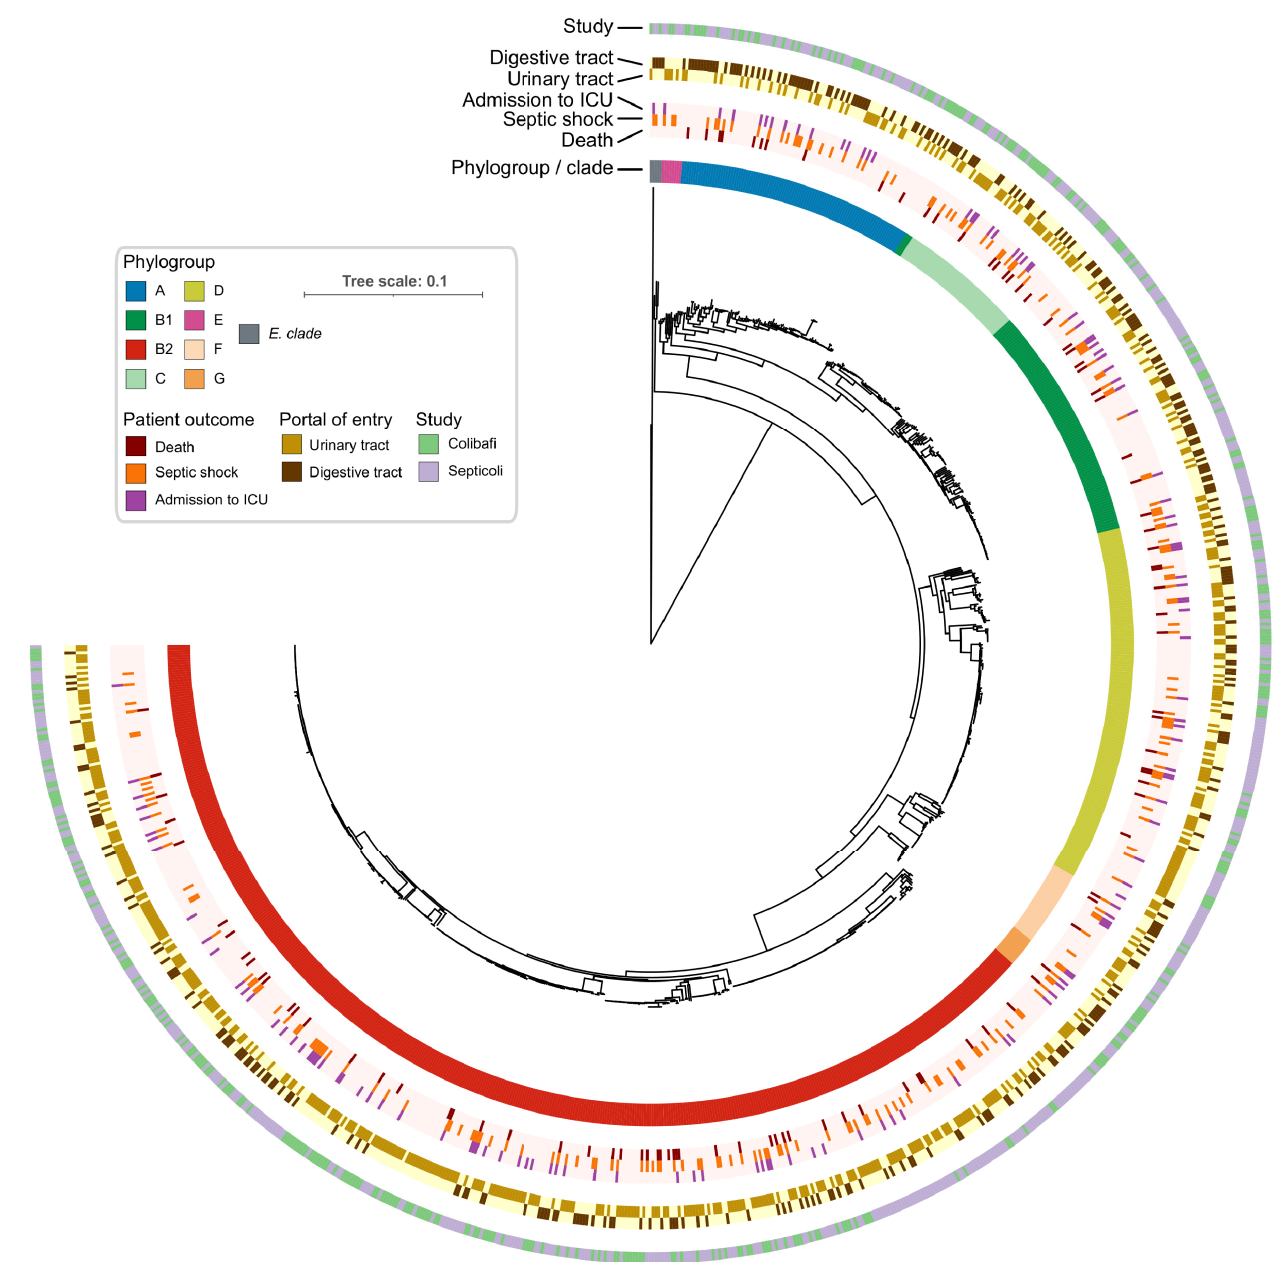
Fig 1. Core genome phylogenetic tree of the 912 E . coli isolates used in this study. Each ring reports the main bacterial and clinical variables of this study. The light color in the rings related to patient outcomes and portals of entry indicates the absence of the trait. https://doi.org/10.1371/journal.pgen.1010112.g001 unitigs generated from a de Bruijn graph of all the bacterial isolates against the target variables [22,23]; namely the three patient outcomes and the two major portal of entry for BSI. We used a linear mixed model for the association, which has been shown to better correct for the influ- ence of bacterial population structure in the association [24]. In order to account for the host and clinical factors on target variables, we conducted the association with the clinical variables